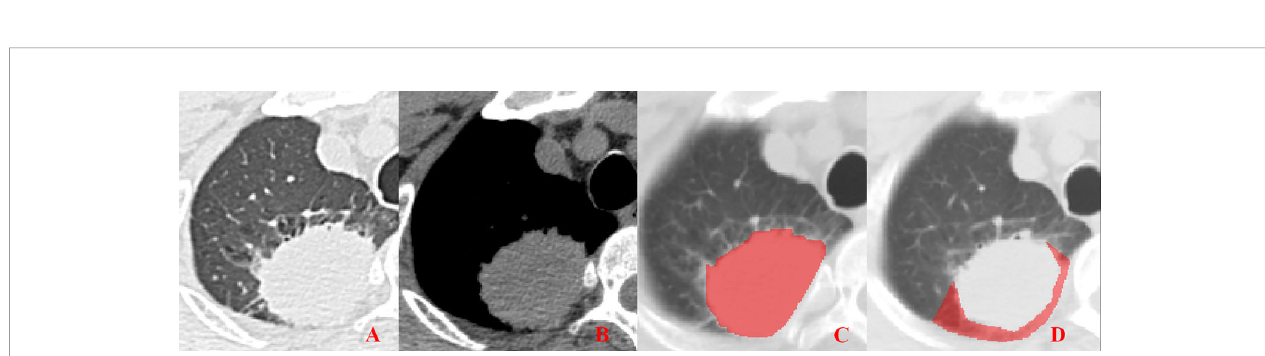
FIGURE 3 | Pleural involvement of Type II. (A, B) Linear or cord-like shadows are observed between the tumor and pleura in both the lung window and mediastinal window images. (C, D) ROI delineation of the primary tumor and nearby pleura.